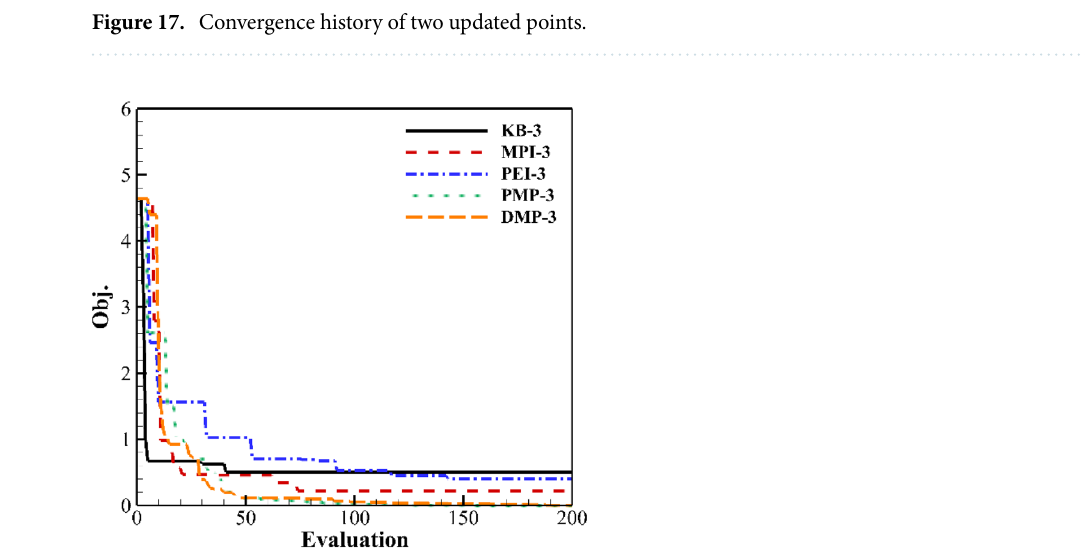
Figure 18. Convergence history of three updated